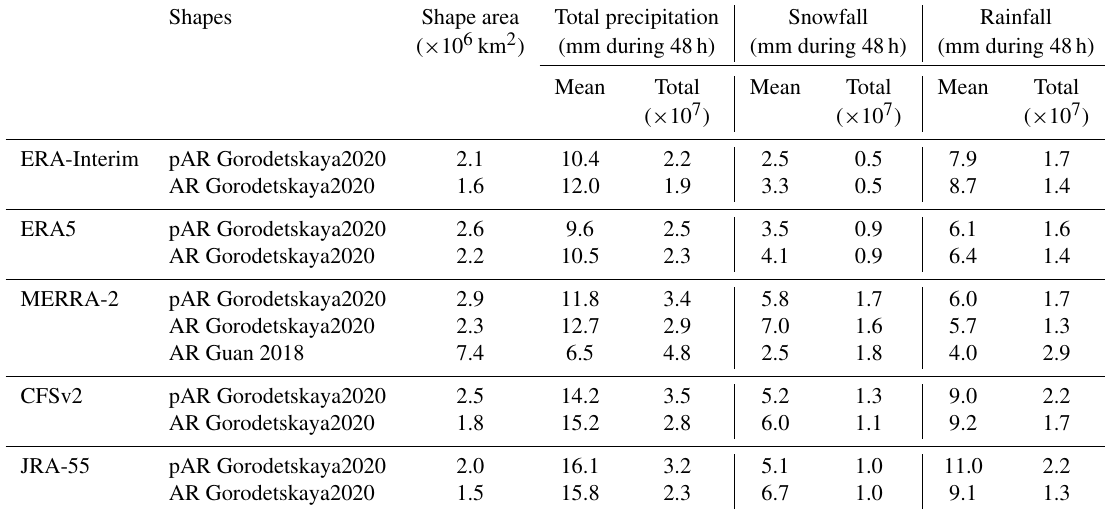
Table 2. Total and mean total precipitation, snowfall, and rainfall amounts within the pAR/AR shapes by Gorodetskaya2020 and Guan2018 (mm during 48h) based on reanalyses (ERA-Interim, ERA5, MERRA-2, CFSv2, and JRA-55) during the 30 May 2017 event. Shapes Shape area Total precipitation Snowfall